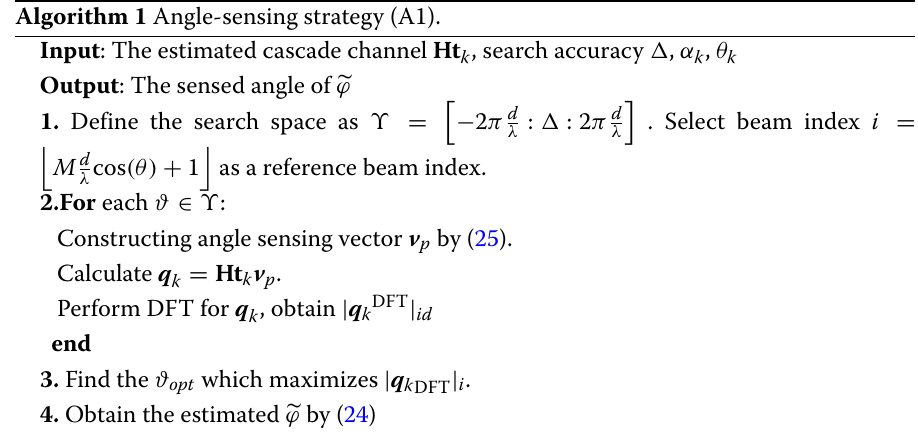
Algorithm 1 Angle-sensing strategy